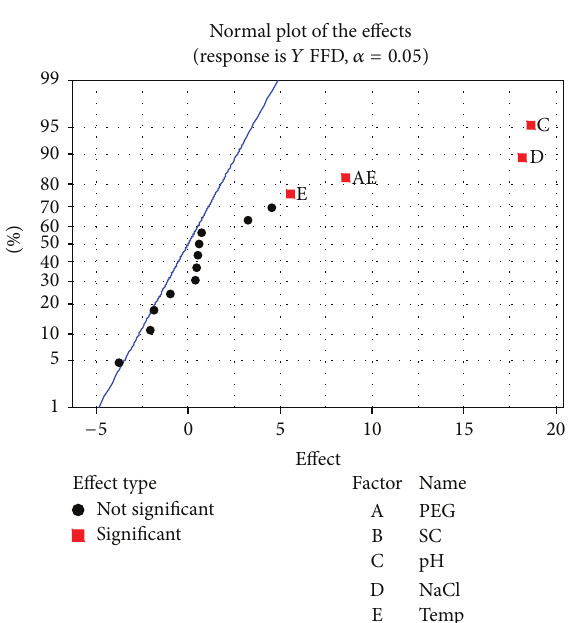
Figure 1: Normal probability plot of the